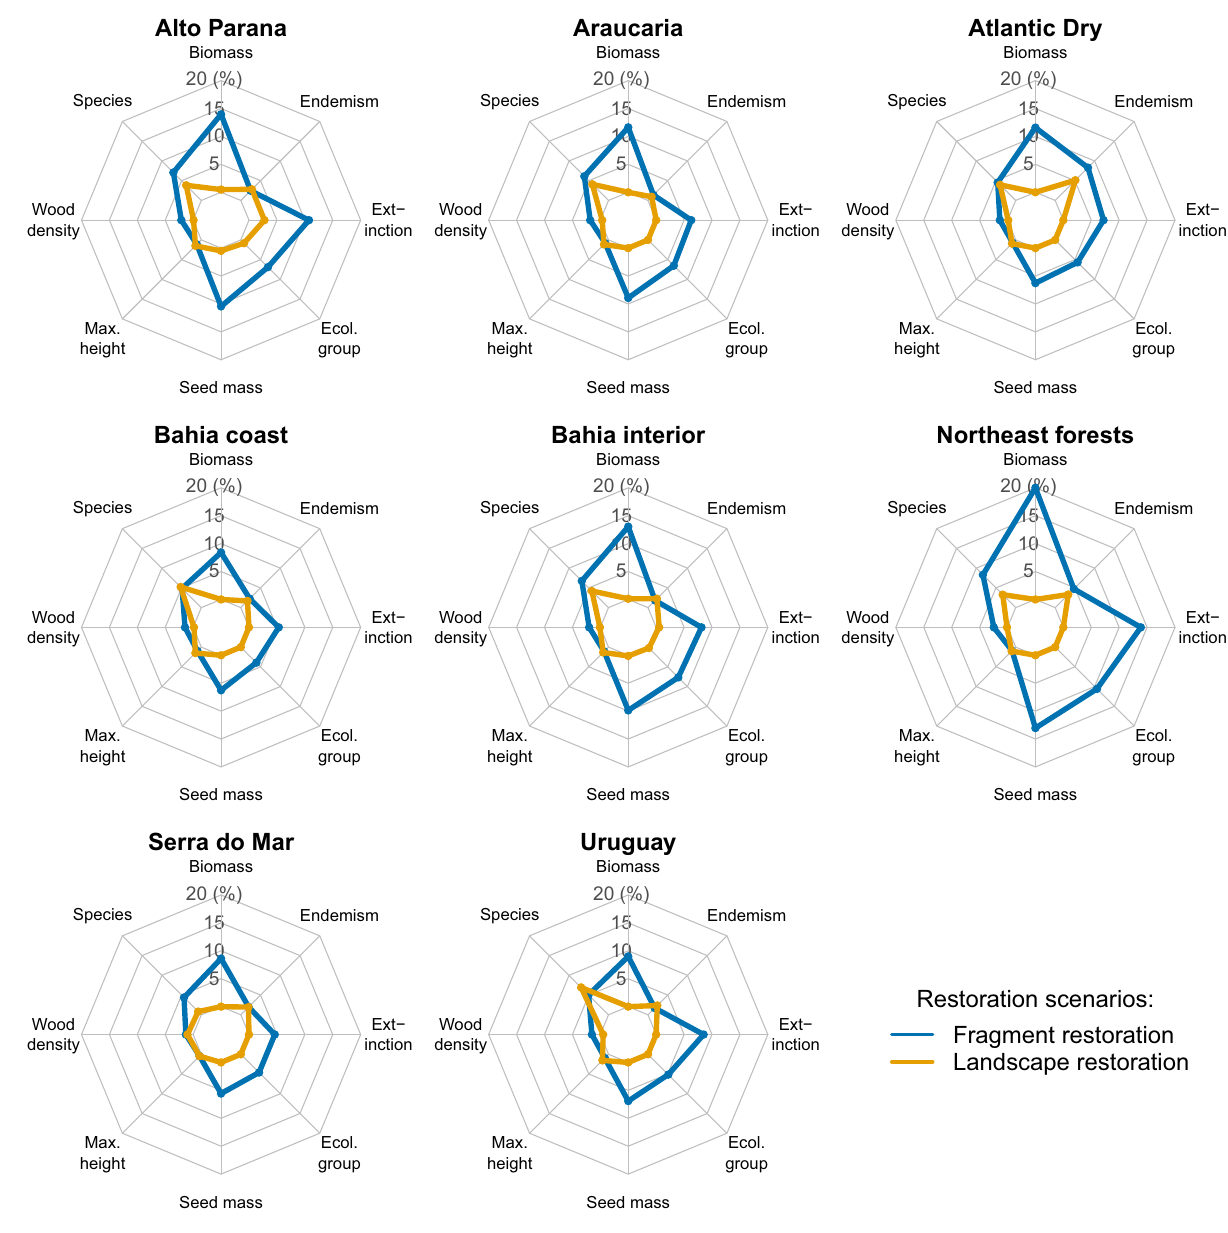
Fig. 7 Multiple outcomes of two restoration scenarios of the Atlantic Forest. In each radar plot, we provide the proportional gain of forest biomass, species richness, wood density, maximum adult height, seed mass, ecological groups, extinction, and endemism levels for the ‘ Fragment restoration ’ (blue line) and ‘ Landscape restoration ’ scenarios (orange line). Gains (in %) are the difference between each restoration scenario and the ‘ current scenario ’ (see Methods), which are presented separately for each biogeographical region of the Atlantic